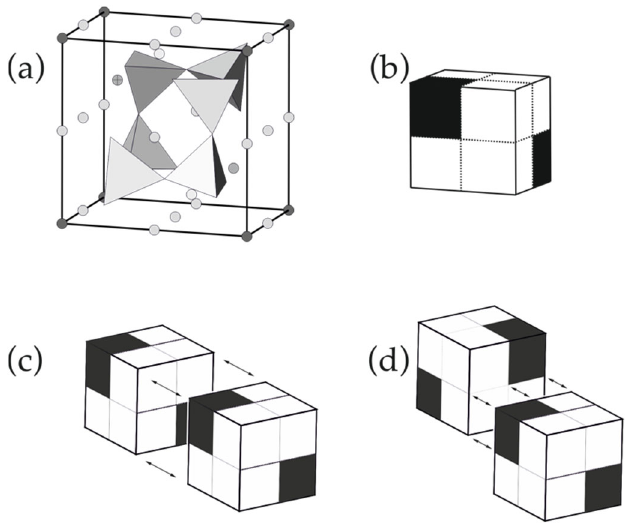
Figure 2. The pseudo ‐ cubic module in the lovozerite ‐ type structures ( a ) ; the schematic representa ‐ tion of SiO 4 tetrahedra is shown in polyhedral mode, whereas all other atoms are shown as spheres ( b ) ; white cubes are occupied by SiO 4 tetrahedra, whereas black cubes are vacant, and the two pos ‐ sible models of modular linkages through a whole face ( c ) and a half ‐ face ( d ). Modified after